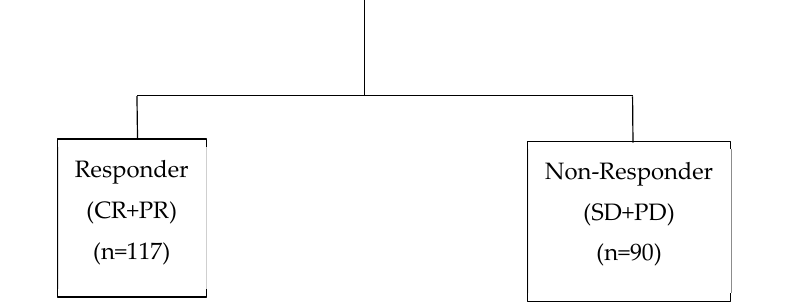
Figure 1. Study flow diagram. Table 1. Patient factors, pathological factors, and pre-treatment laboratory results of responder and non-responder groups (207 cases).